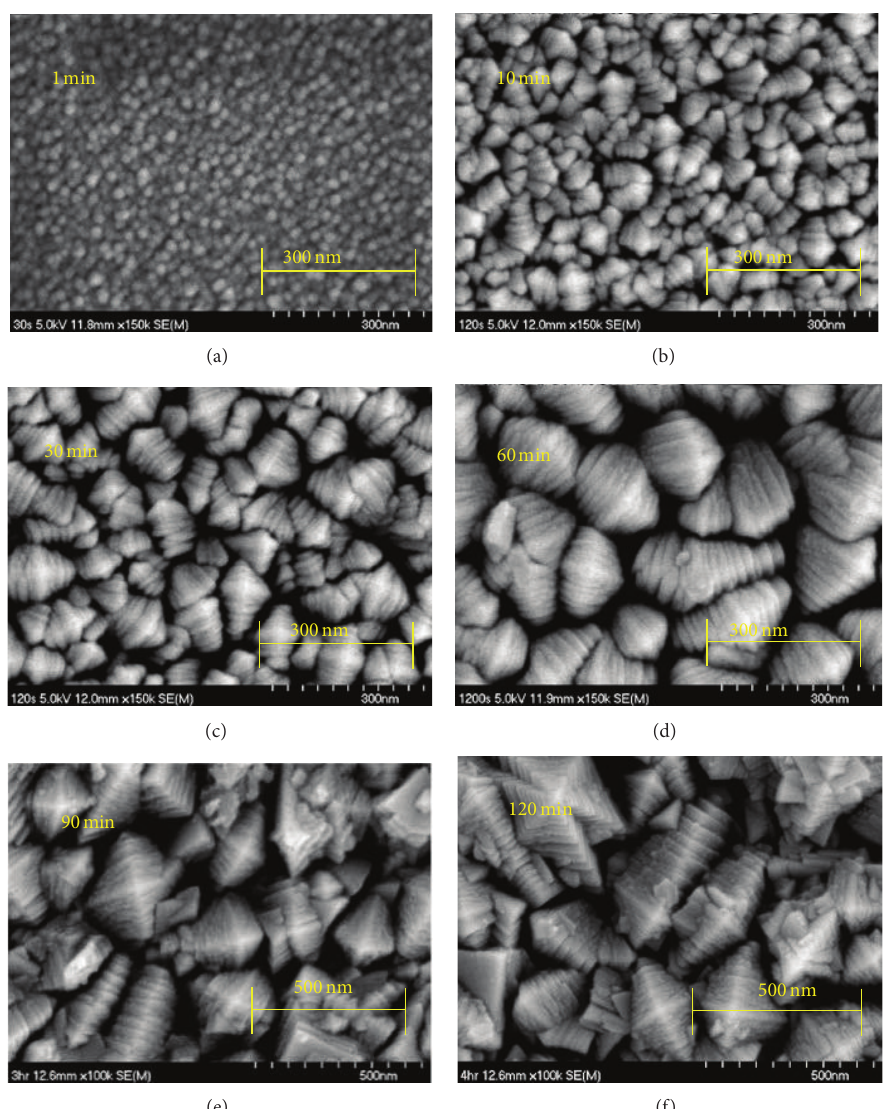
Figure 5: Surface morphology of TiO 2 films grown by CVD at different deposition